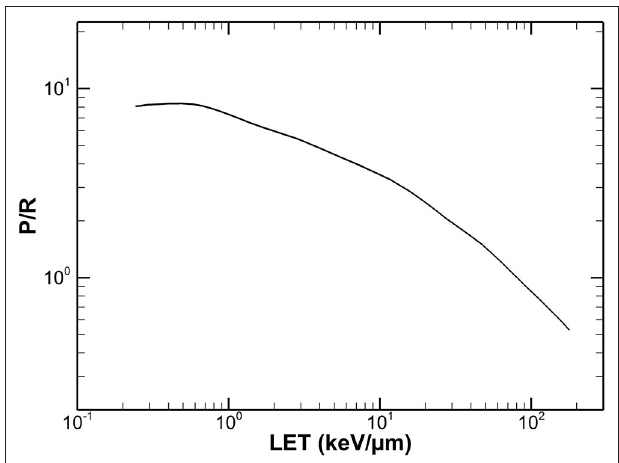
FIGURE 6 | Simulated ratio of damages to membrane and nucleic acids. Geant4-DNA simulation of the ratio of the damages to spike proteins and RNA (P/R ratio) for radiation of different LET (in keV/ µ m in water). The curve provides only the trend as a function of the LET alone, the actual points showing the complex dependence from the velocity and charge can be found in reference [42].